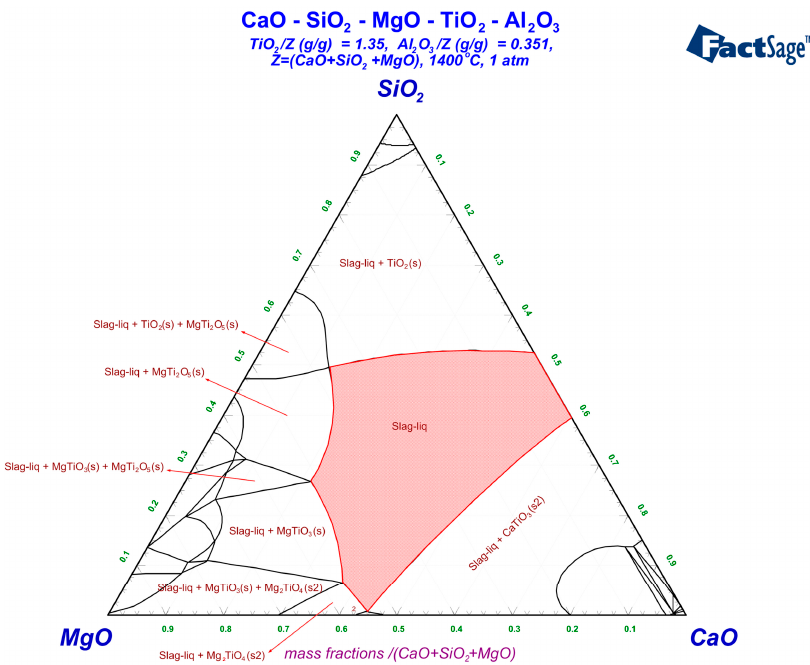
Figure 3. Isothermal section of phase diagram of CaO ‐ SiO 2 ‐ MgO ‐ TiO 2 (50%) ‐ Al 2 O 3 (13%) at 1400 °C.